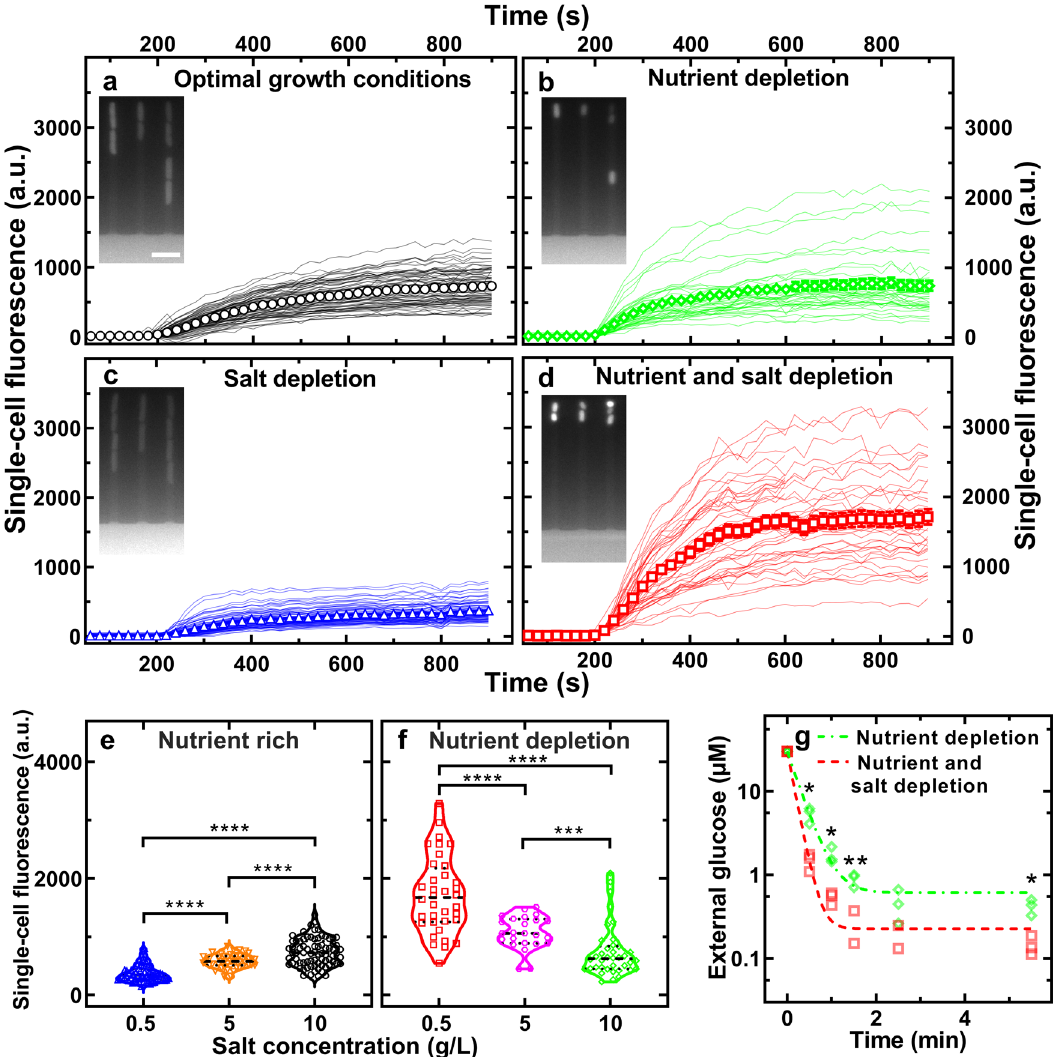
Fig. 2 Glucose accumulation is greatest under combined nutritional and salinity depletion. Temporal dependence of the mean intracellular fl uorescence of the glucose analogue 2-NBDG in individual E. coli under ( a ) optimal growth conditions, ( b ) nutrient depletion, ( c ) salt depletion or ( d ) combined nutrient and salt depletion. Lines are temporal dependences of the intracellular fl uorescence of individual bacteria collated from biological triplicate. Symbols and error bars are the corresponding means and standard error of the means of such single-cell measurements. Noteworthy, we measured the 2-NBDG fl uorescence as the mean fl uorescent values of each pixel constituting each bacterium, thus normalizing by cell size. Coef fi cient of variations of these single-cell values and statistical tests of quantitative comparisons of values between different environments are reported in Supplementary Tables 2 and 3, respectively. Corresponding 2-NBDG intracellular fl uorescence values during the removal of extracellular 2-NBDG are reported in Supplementary Fig. 5. Insets: corresponding fl uorescence images at t = 900 s when the intracellular 2-NBDG accumulation has reached saturation levels in individual bacteria. Measurements were carried out on N = 76, 38, 90 and 46 individual bacteria, in ( a ) – ( d ), respectively. Salinity-dependent distribution of single-cell fl uorescence after 900 s incubation in 2-NBDG in ( e ) nutrient-rich or ( f ) nutrient-depleted environments. Dashed and dotted lines indicate the median and quartiles of each distribution, respectively. g Temporal dependence of the extracellular glucose concentration for E. coli under nutrient (green diamonds) or nutrient and salt depletion (red squares). N = 3 biological replicates for each environment. The dashed dotted and dashed lines are one phase exponential decay fi ttings to the data yielding a signi fi cantly smaller time constant Tau for E. coli under combined nutrient and salt depletion compared to nutrient depletion alone ( Tau = (9 ± 1) s vs (17 ± 1) s, respectively, *). * p value < 0.05, ** p value < 0.01, *** p value < 0.001, **** p value <